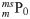
The spatial distribution of initialized control points.The range of curve is the same with that of Fig 6, and it is an eighth of the moving space which is symmetrical around mmsP0. The initialized control points ‘○’ take control of the surrounding space which is partitioned by adjacent control points.